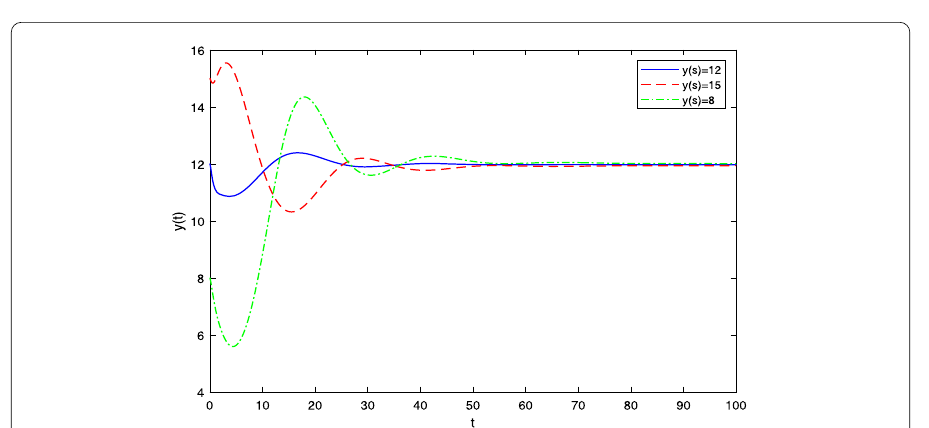
Figure 6 Time responses of state variable y ( t ) with with α =